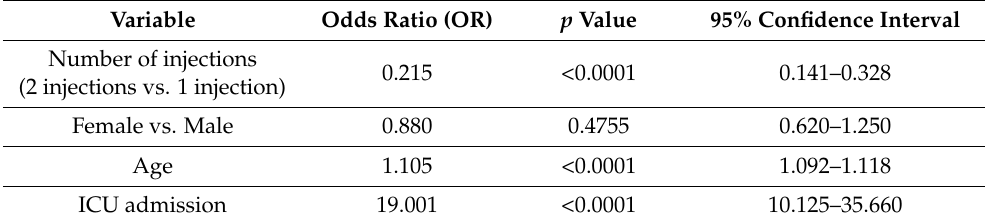
Table 3. Multiple logistic regression for the association between the number of vaccine injections and mortality among vaccinated COVID-19 patients with Oxford–AstraZeneca vaccine (n = 39,320). Variable Odds Ratio (OR)